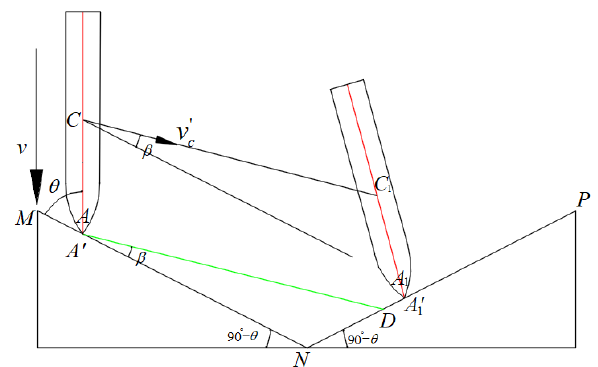
Figure 1. Geometric diagram of the projectile obliquely penetrating the target.